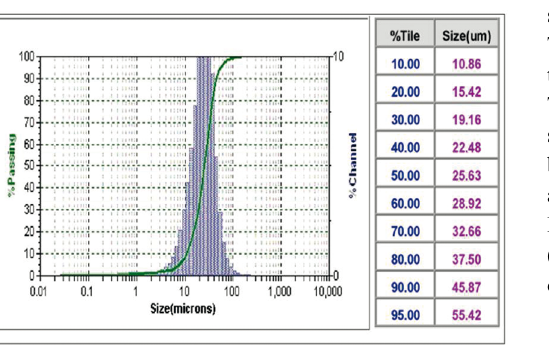
Figure 3. Particle size distribution curve and mean diameter distribution by volume of the APT particles. Morphological analysis of APT